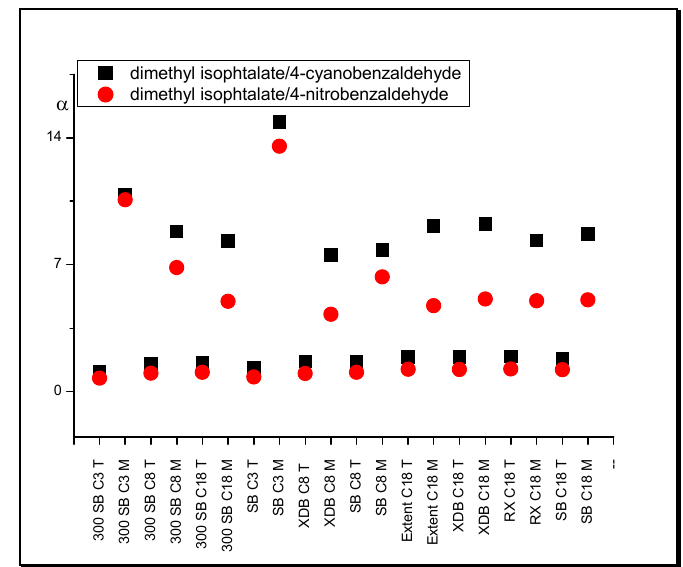
Figure 7. Separation factor, α , values of hydrocarbons with different functional groups in systems with different nonpolar stationary phases and methanol (M) in water and tetrahydrofuran (T) in water (modifier concentrations as in Table 1).